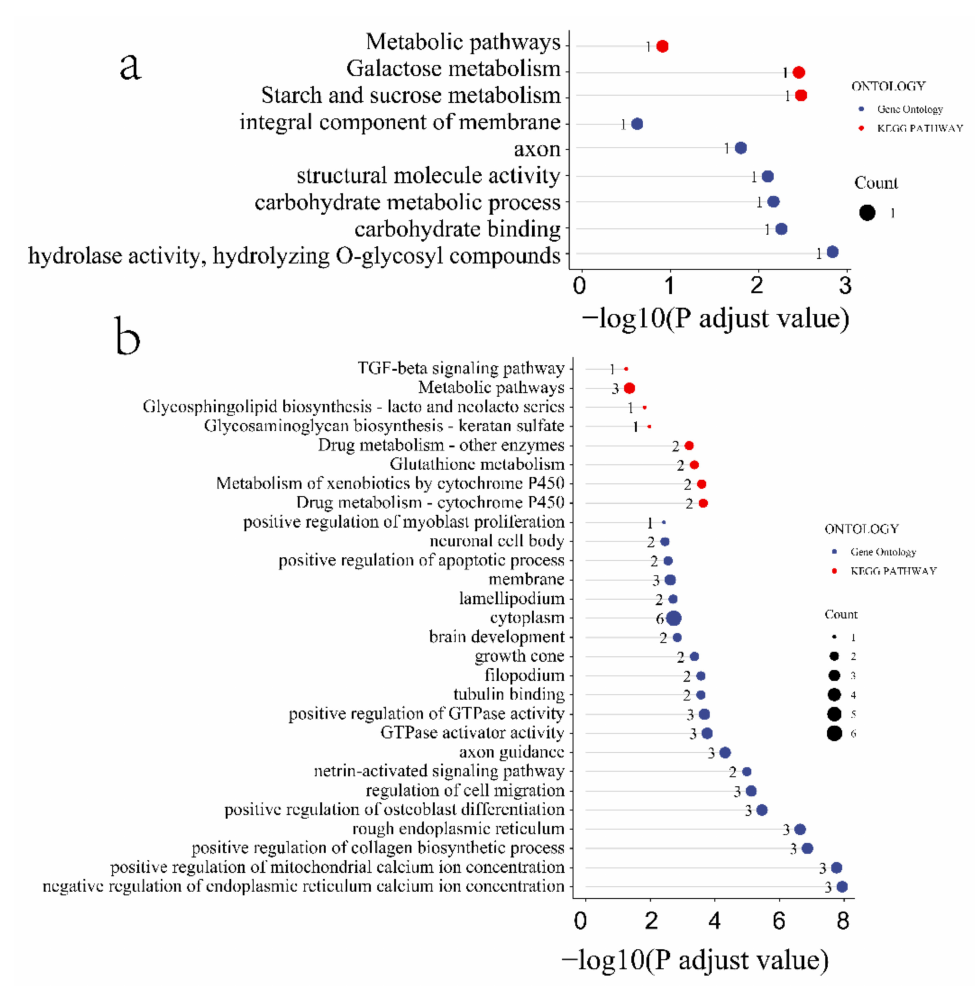
Figure 4. Functional enrichment analysis of the FE trait-related candidate genes. ( a ) Feed in- take, ( b ) residual feed intake. Red and blue colored ribbons represent GO terms and KEGG pathways,